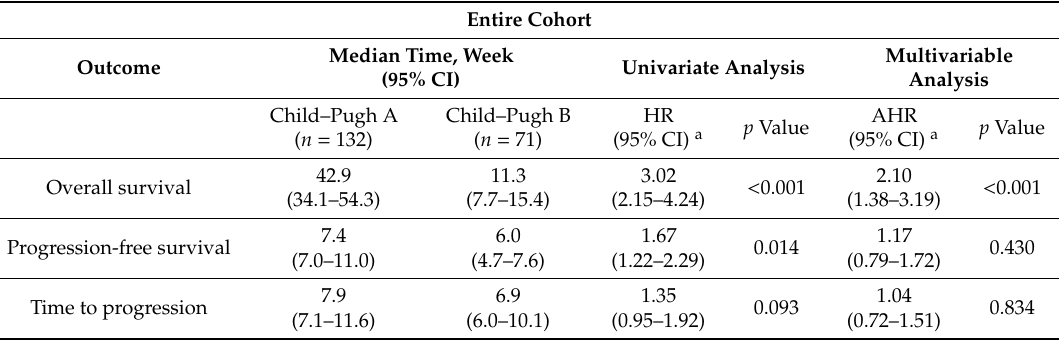
Table 4. Survival outcomes of the study population.